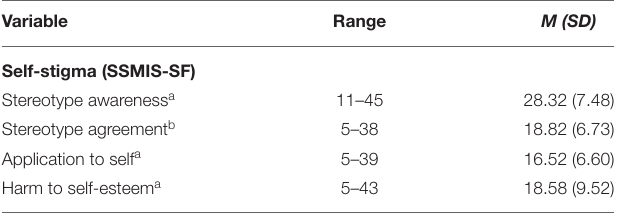
TABLE 2 | Mental health self-stigma scores in the analysis sample ( N = 133).